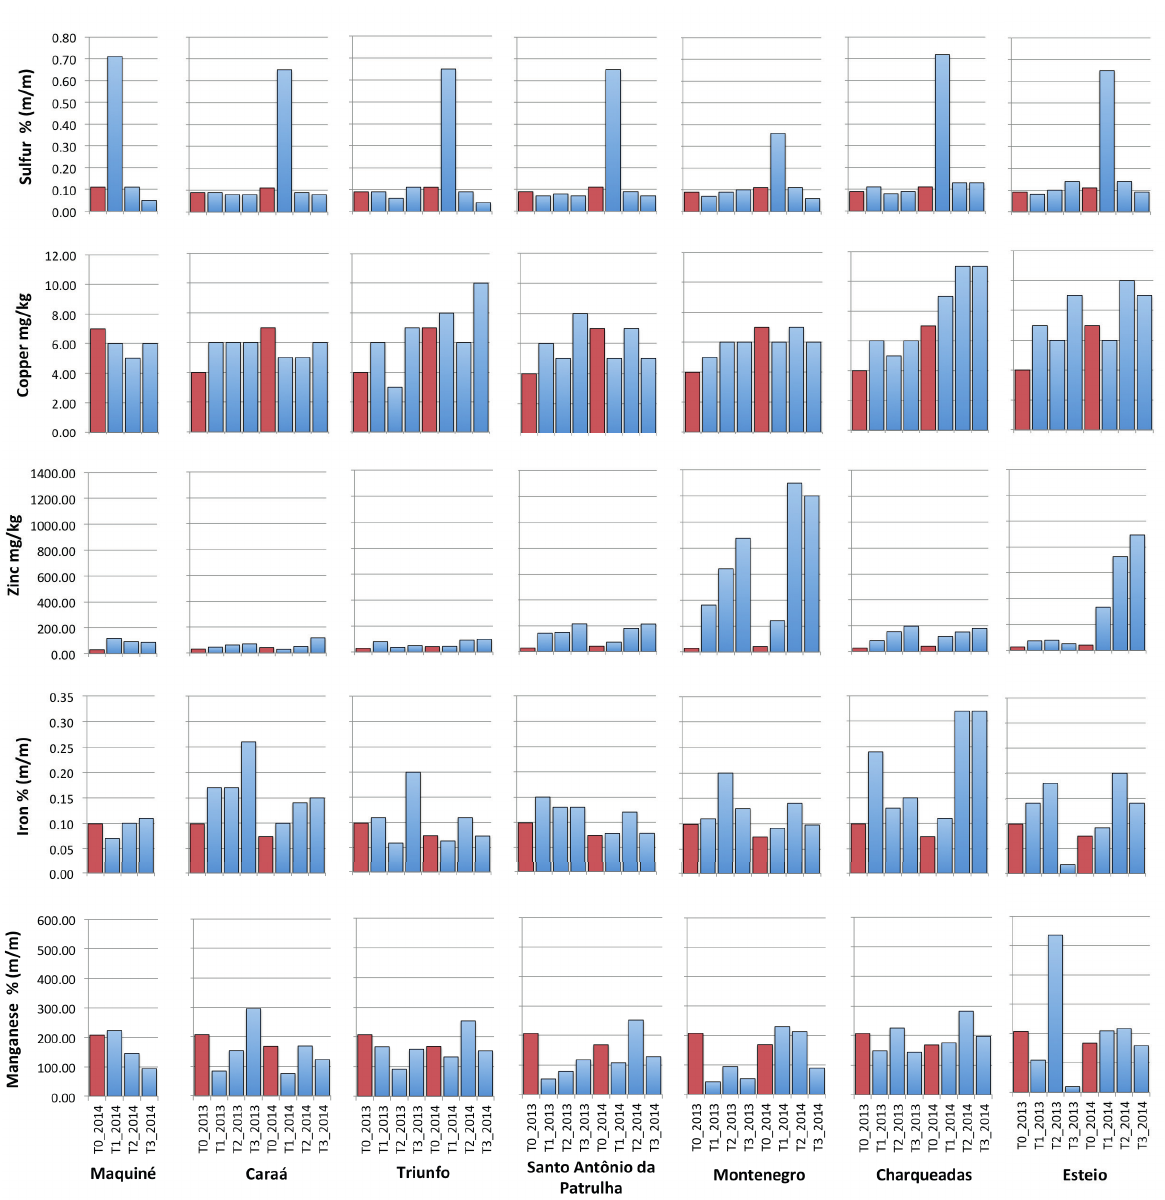
Figure 3 - Contents of sulphur and metals absorbed by the lichen Parmotrema tinctorum during seven months of exposure in 2013 and 2014. The red column represents the basal values, prior to exposure in the cities. T0 = contents prior to exposure; T1 = after two months; T2 = after fi ve months; T3 = after seven